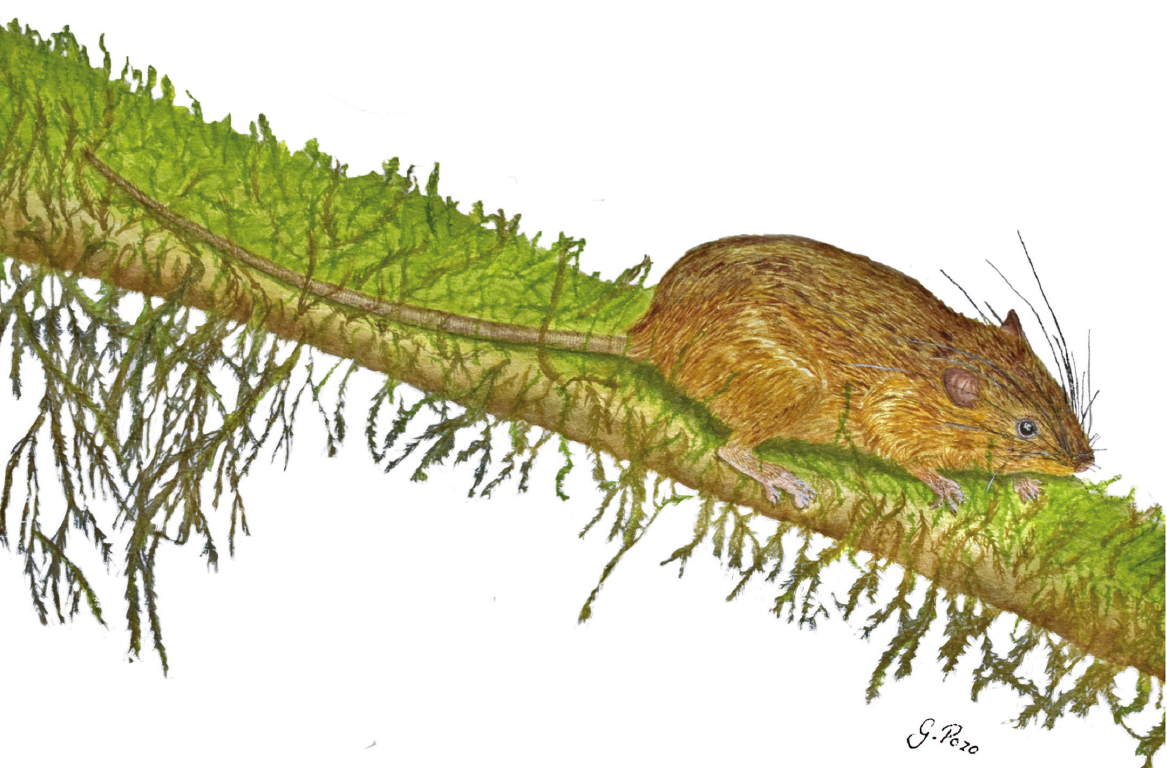
Figure 6. External aspect of Mindomys kutuku sp. nov., in its natural habitat (painted by Glenda